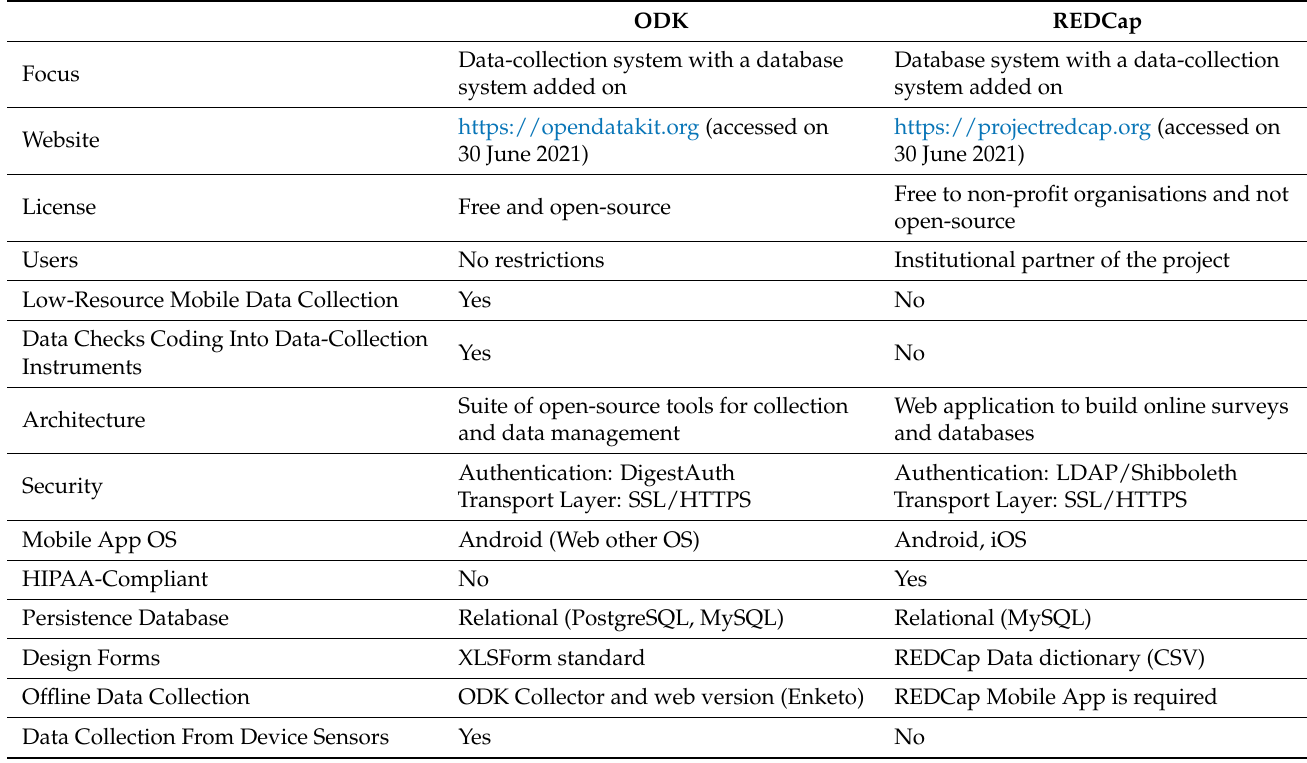
Table 2. Key features of the free and open-source Open Data Kit (ODK) software used to implement the four modules of EULAT eCollect compared to the Research Electronic Data Capture (REDCap) web application, one of the leading platforms for capturing and processing clinical information. ODK REDCap Data-collection system with a